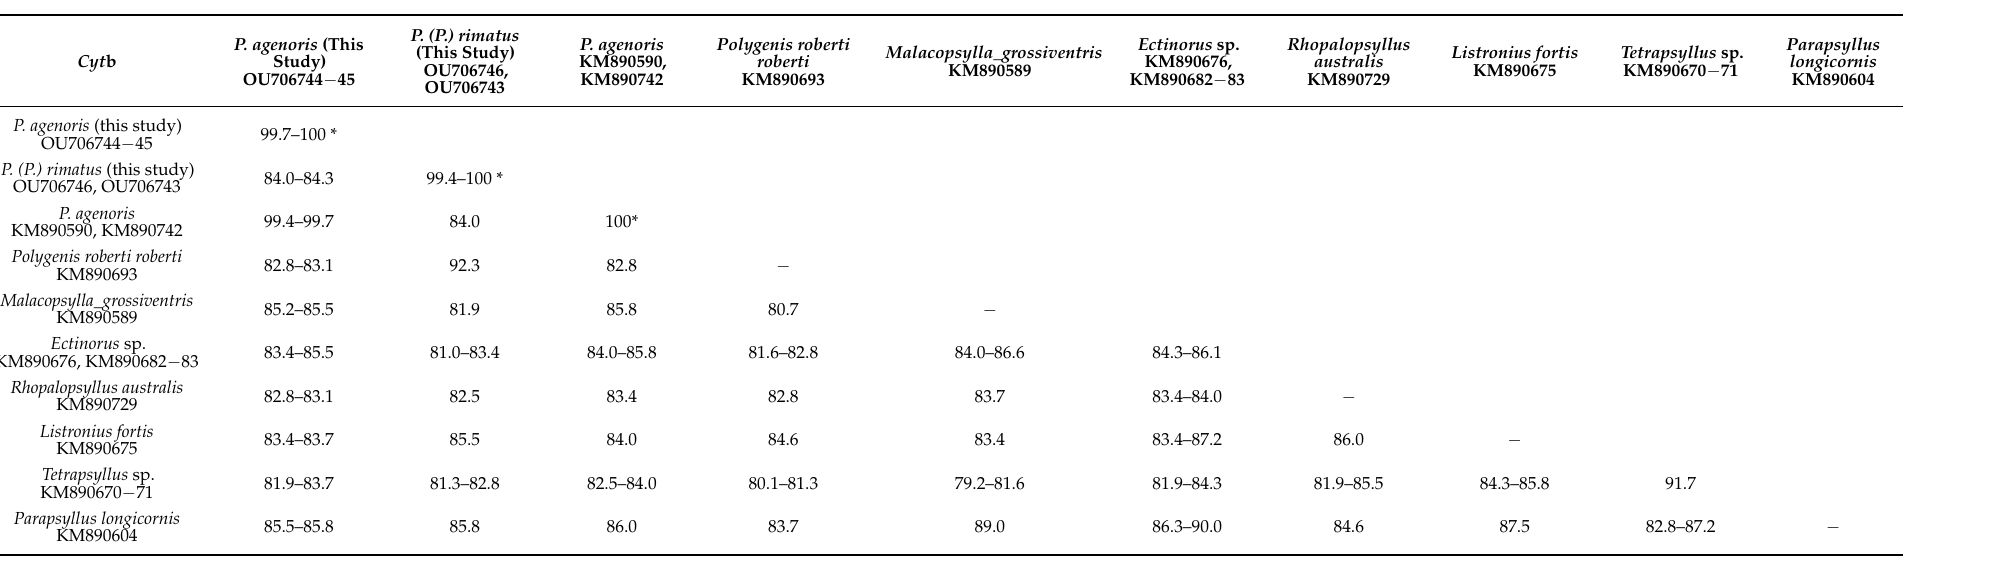
Table 4. Intraspecific (*) and interspecific similarities observed among all partial ctyb mtDNA gene sequences of P. agenoris and P. (P.) rimatus (obtained in this study) and different species and genera belonging to Rhopalopsyllidae and Malacopsyllidae families retrieved from GenBank database. Values are given in